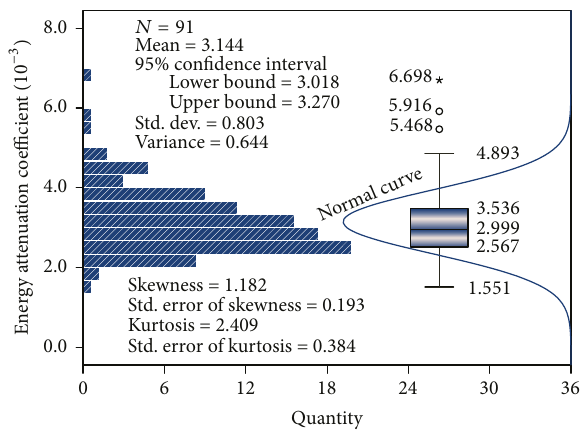
Figure 7: Histogram, boxplot, normal test, and Q-Q plot of observed EAC